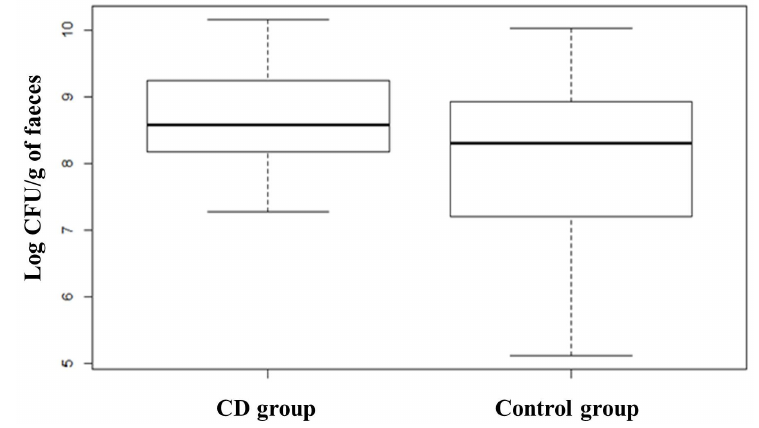
Figure 9. Box plots showing qPCR analysis of Bacteroides fragilis group expressed in log CFU per gram of faecal sample relative to CD group and Control group. CD group is composed of Probiotic T0, Placebo T0 and Placebo T1 samples. Statistical difference between the two groups ( p -values of < 0.01).